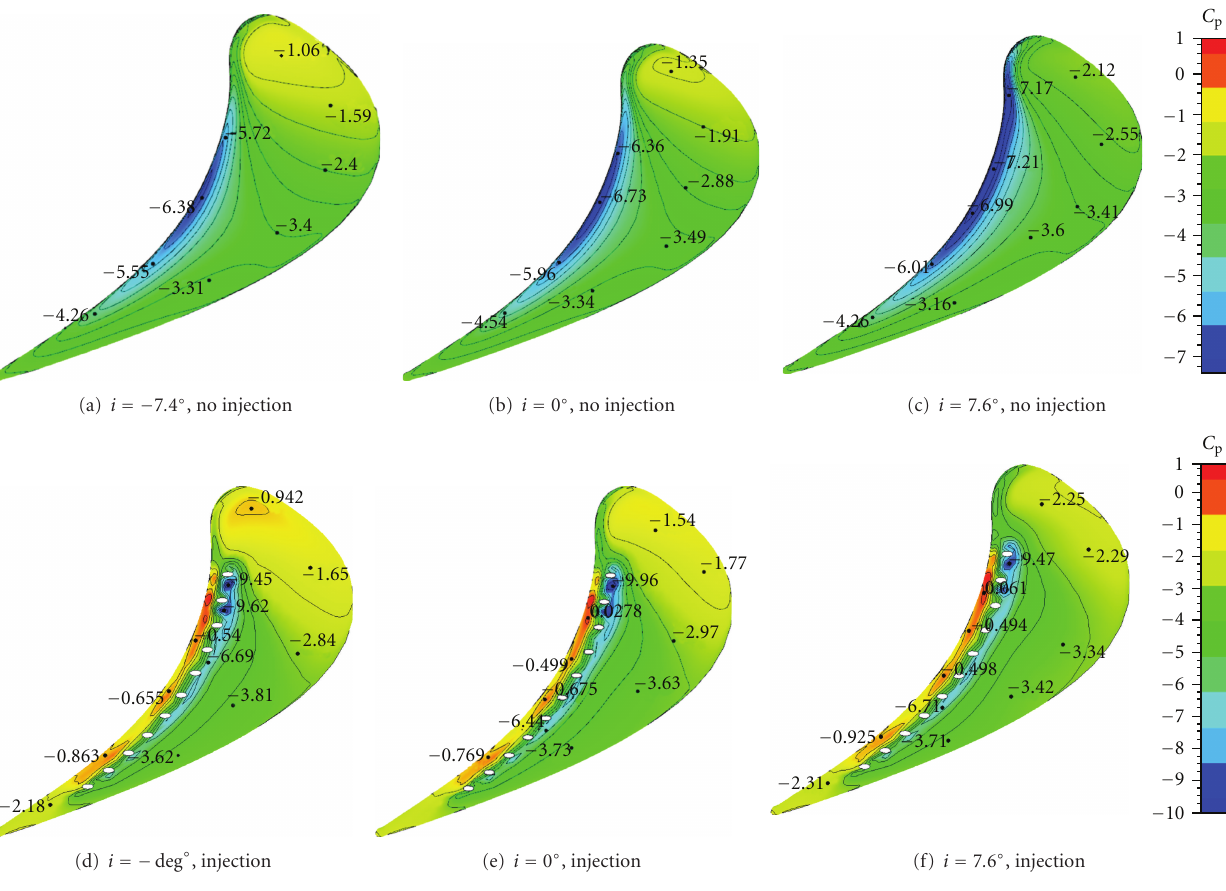
Figure 4: Distribution of static pressure coe ffi cient on the blade tip surface.